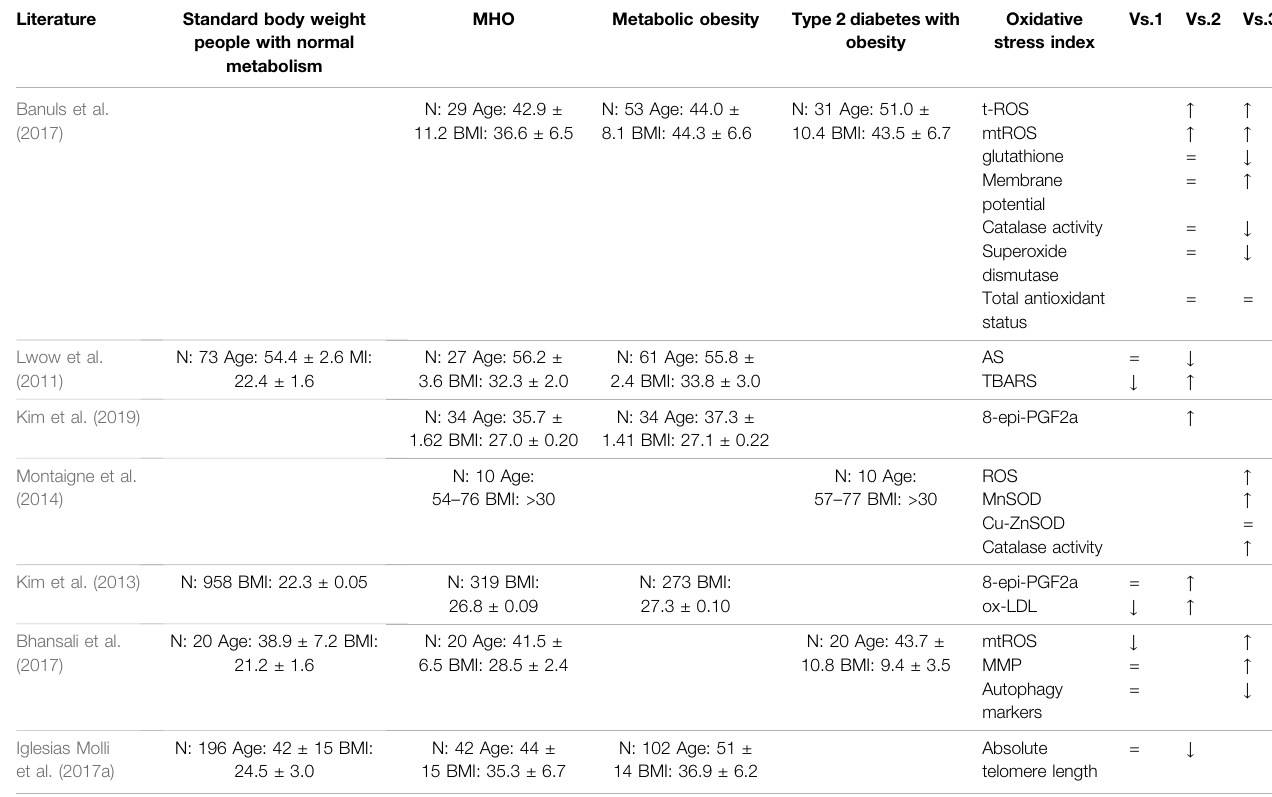
MHO Metabolic obesity Type 2 diabetes with